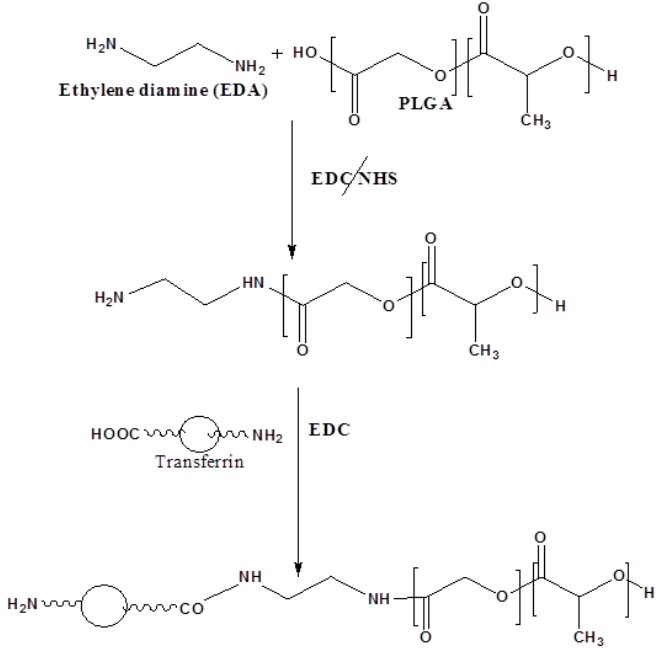
Figure 1. Synthesis of the poly(lactide ‐ co ‐ glycolide) (PLGA)–EDA–transferrin conjugate. A solution of PLGA (0.01 mmol), 1 ‐ ethyl ‐ 3 ‐ (dimethylaminopropyl) carbodiimide (EDC) (0.08